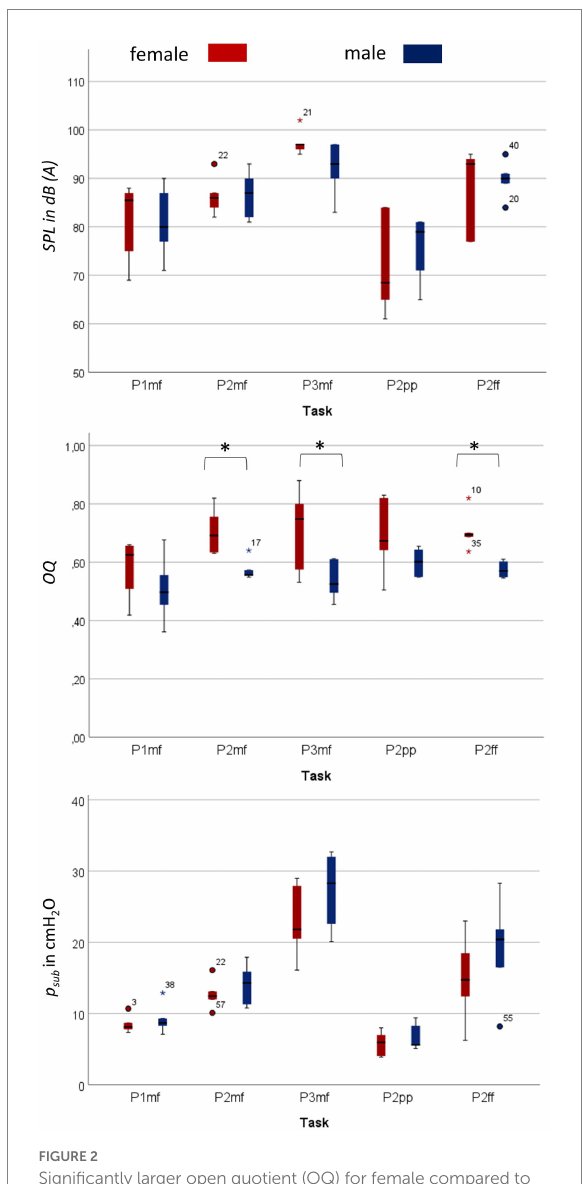
FIGURE 2 Significantly larger open quotient (OQ) for female compared to male singers in the respective task, no significant difference for subglottic pressure ( p sub ) and sound pressure level (SPL). The figure shows boxplots of OQ, p sub and SPL for each task separately for male and female singers. An increase in p sub can be seen from the lowest to highest pitch (P1 mf to P2 mf to P3 mf) as well as from the lowest to the highest loudness condition (P2 pp to P2 mf to P2 ff). The same trajectory can also be seen for the measured SPL. No significant difference is found between male and female singers. In contrast, while OQ increases with pitch in female singers, no pitch-dependent relationship was found for male singers. Significant differences are marked with *. Details on statistic evaluation can be found in Supplementary Table S1.